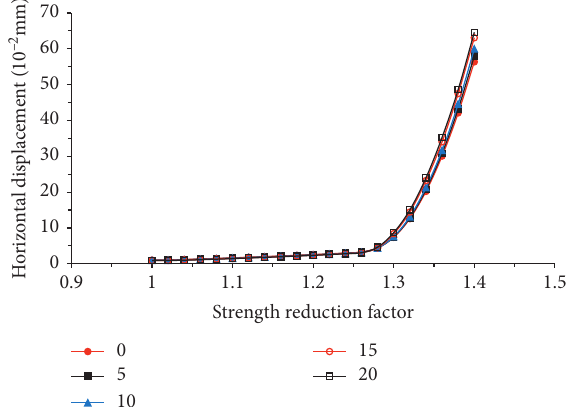
Figure 3: The curves of horizontal displacement versus the SRF with different dilation angles.